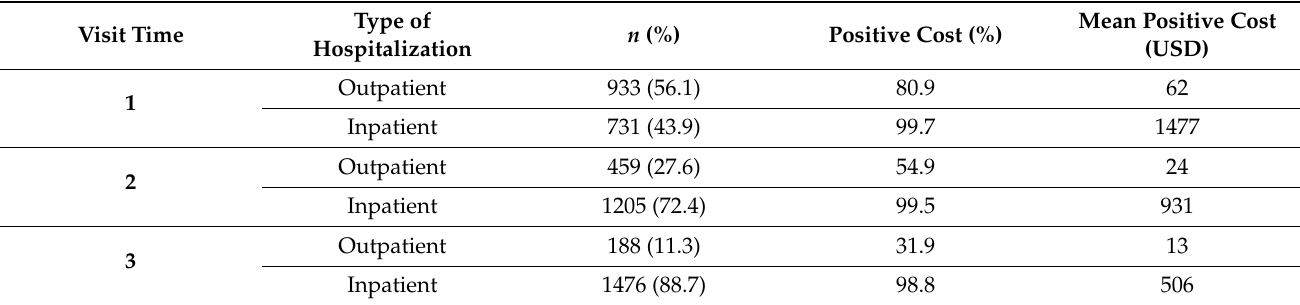
Table 6. Summary of time-dependent covariate (type of hospitalization) fitted to the HDK